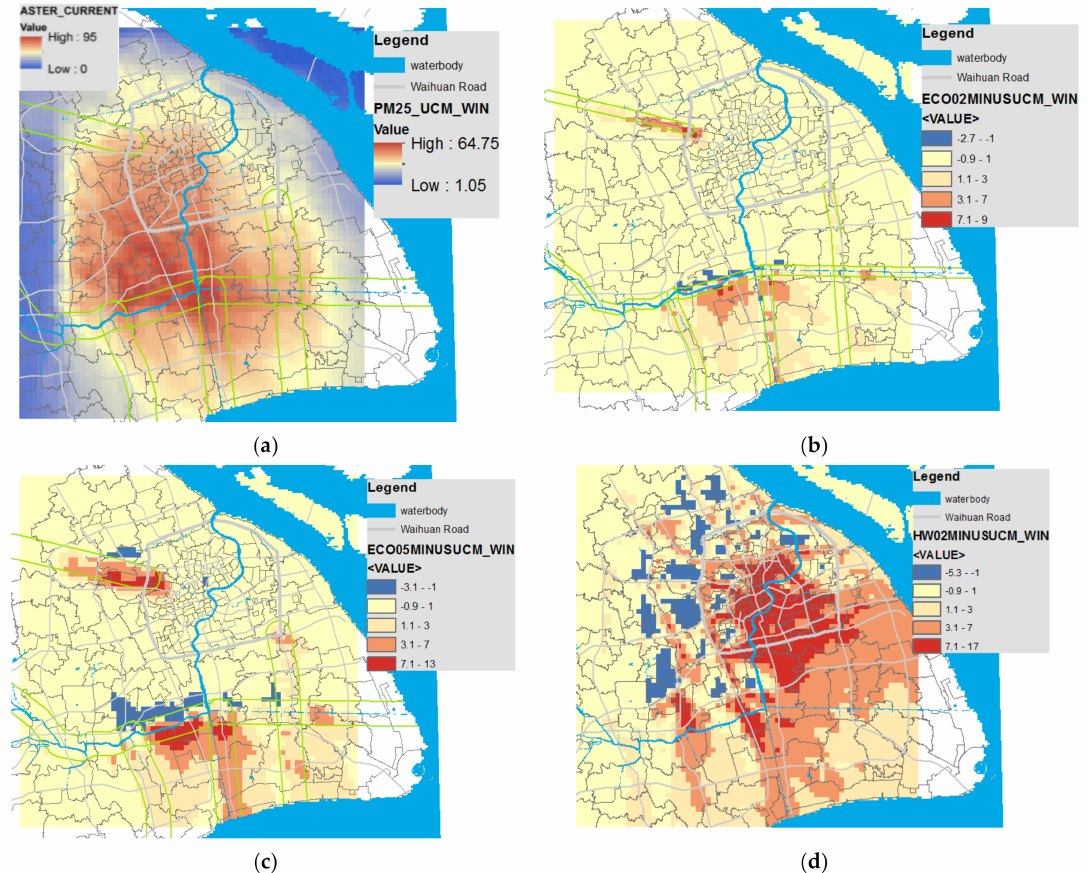
Figure 9. ( a ) Modeling ground-level PM2.5 concentrations ( µ g/m 3 ) in winter 2014; ( b ) modeling ground-level PM2.5 concentration differences ( µ g/m 3 ) in the ECO02 scenario and base scenario; ( c ) modeling ground-level PM2.5 concentration differences ( µ g/m 3 ) in the ECO05 scenario and base scenario; ( d ) modeling ground-level PM2.5 concentration differences ( µ g/m 3 ) in the HW02 scenario and base scenario.